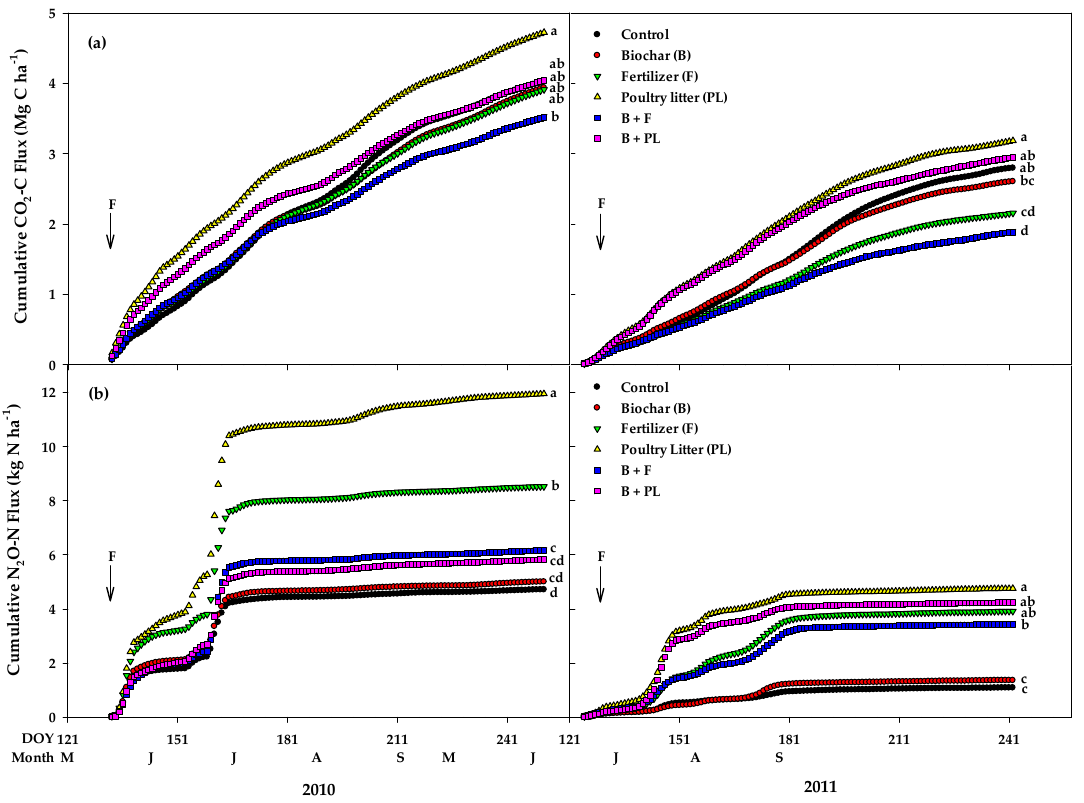
Figure 4. ( a ) Cumulative CO 2 -C and ( b ) N 2 O-N emissions for each treatment during the 2010 and 2011 growing seasons as a function of day of year (DOY). Cumulative values within each year for same effect followed by the same letters are not significantly different according to Fisher’s LSD (0.05) level. B, biochar; F, fertilizer; PL, poultry litter.